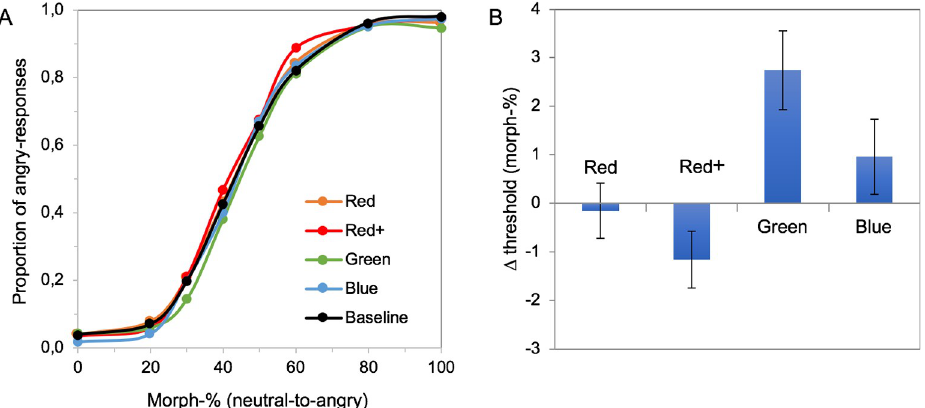
Fig 5. The effect of background color on anger perception. (A) Psychometric functions showing anger recognition performance as a function of morph level for each background condition, averaged across participants (N = 19). (B) Average color-induced change in the 50% threshold for each background color. Error bars represent +/-1 standard error of the mean across 19 participants.